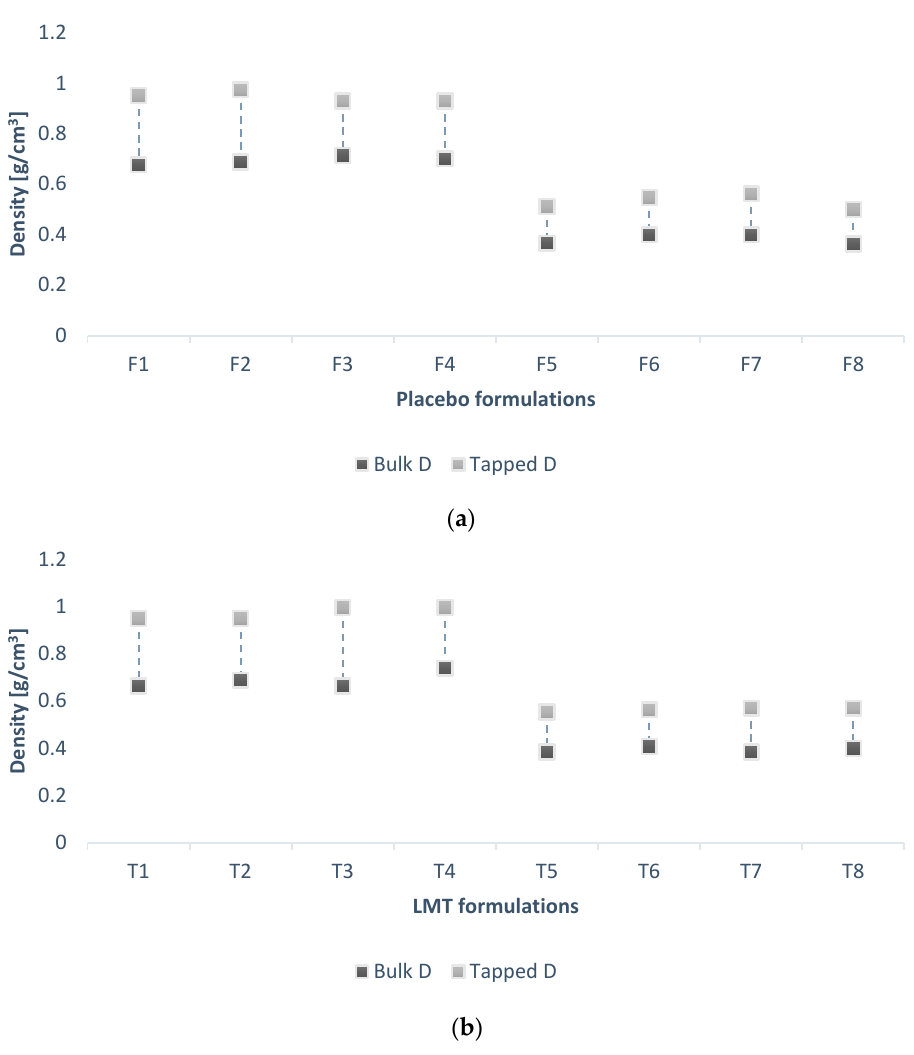
Figure 1. Comparative diagram of bulk and tapped densities of ( a ) placebo formulations (F1–F8) and ( b ) formulations with LMT (T1–T8).